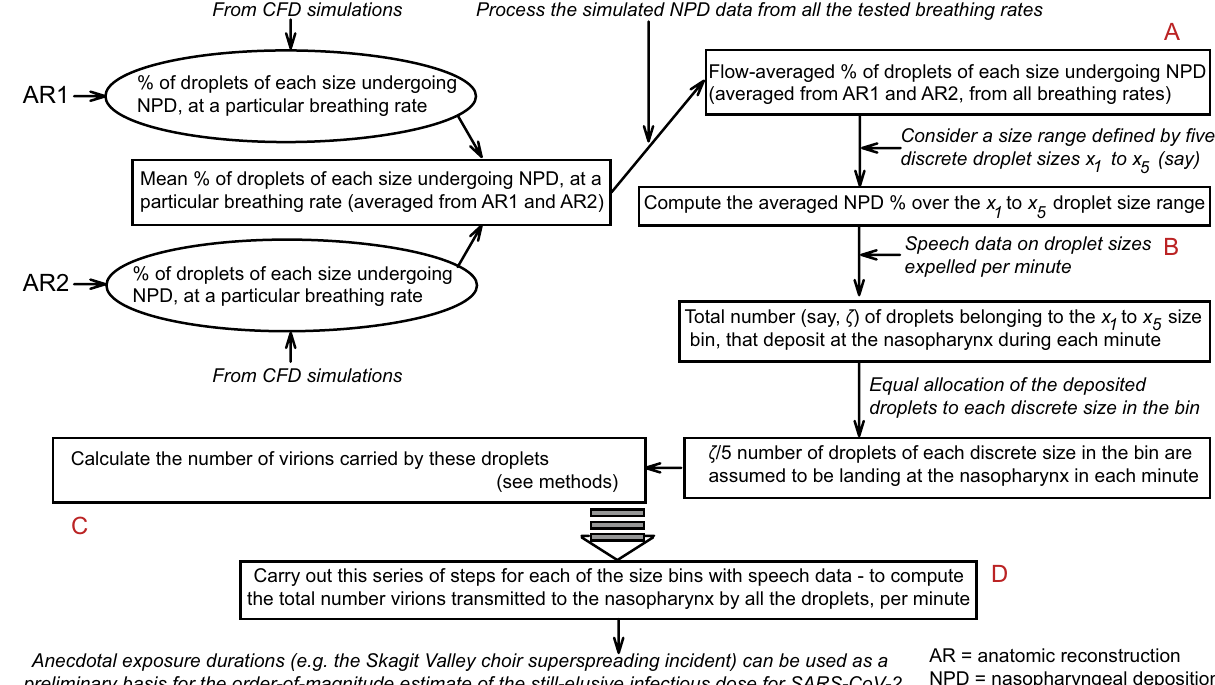
Figure 2. Logic diagram: for each tested breathing rate, the simulations generate the percentage of droplets of each size that undergo nasopharyngeal deposition (NPD) in AR1 and AR2. From that data, we compute the mean NPD for each droplet size, at each inhalation rate. Next, considering the mean NPD for all tested airflow rates, we compute the flow-averaged NPD for each droplet size. The NPD% rate for each droplet size is then linked to known data on droplet sizes emitted during regular speech 7 , to figure out how many of those droplets would land at the exposed individual’s nasopharynx. We then compute the virion loading, as a function of the droplet sizes—see “Assessing the probability for at least 1 virion being embedded on a respiratory ejecta droplet emanating from an infected individual” and “Estimating the number of virions transmitted to the nasopharynx” for details of the mathematical framework, to quantify the number of virions (say, β ) that are transmitted by the droplets to the nasopharynx in each unit of time. Finally, to obtain an order-of-magnitude estimate of the infectious dose, we multiply β with the exposure time reported during a known superspreading incident 5 . Alphabets A–D in the above schematic respectively correspond to the computed outputs in Panels percentages for each size bin (i.e. 0–5, 5–10, 10–15 µ etc.) uniformly and apportions them to the discrete